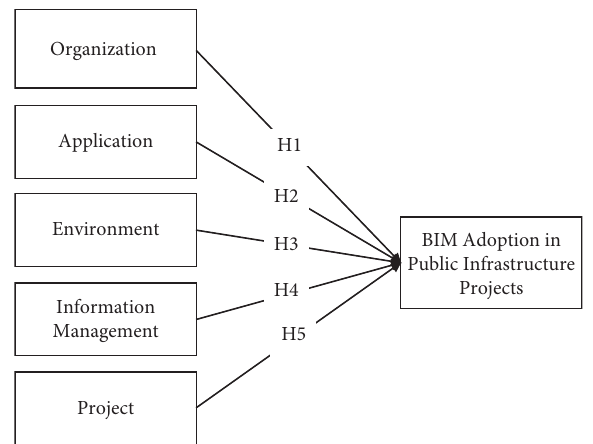
Figure 1: SEM model hypothesis used in this